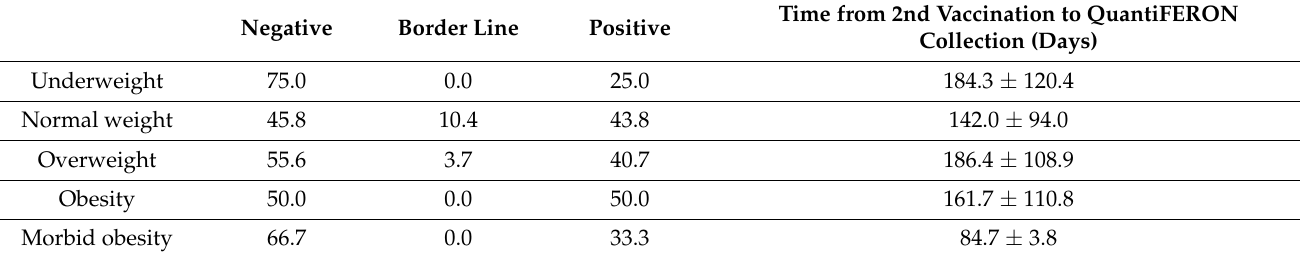
Table 8. Cell-mediated immunity by body mass index (BMI)